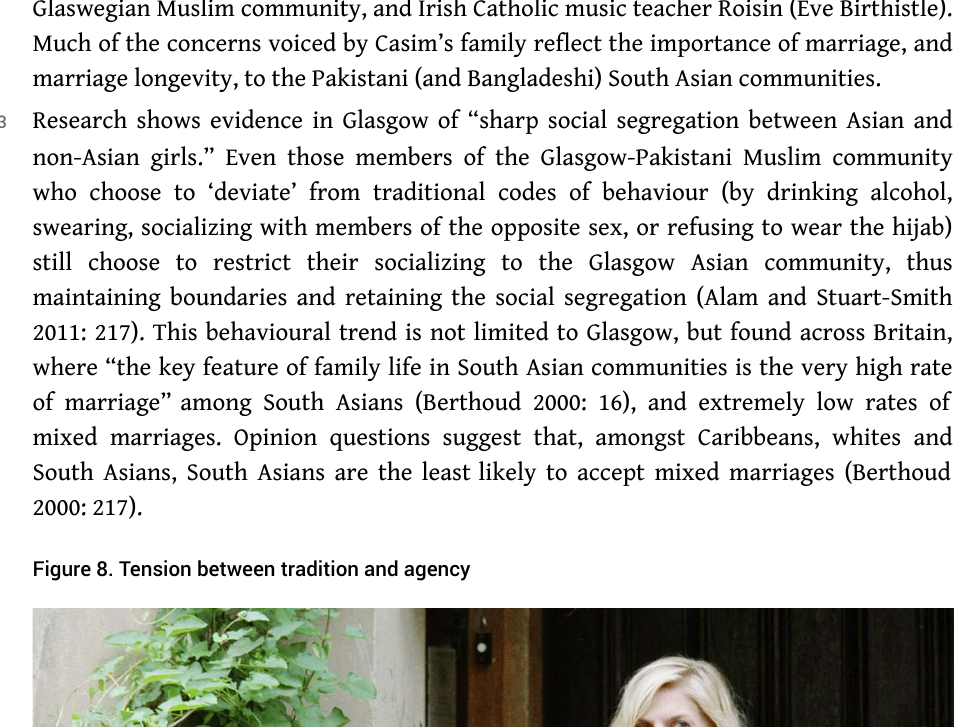
Figure 8. Tension between tradition and agency